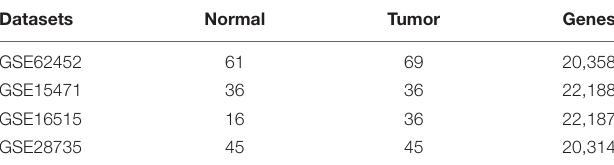
TABLE 1 | Details of GEO datasets of